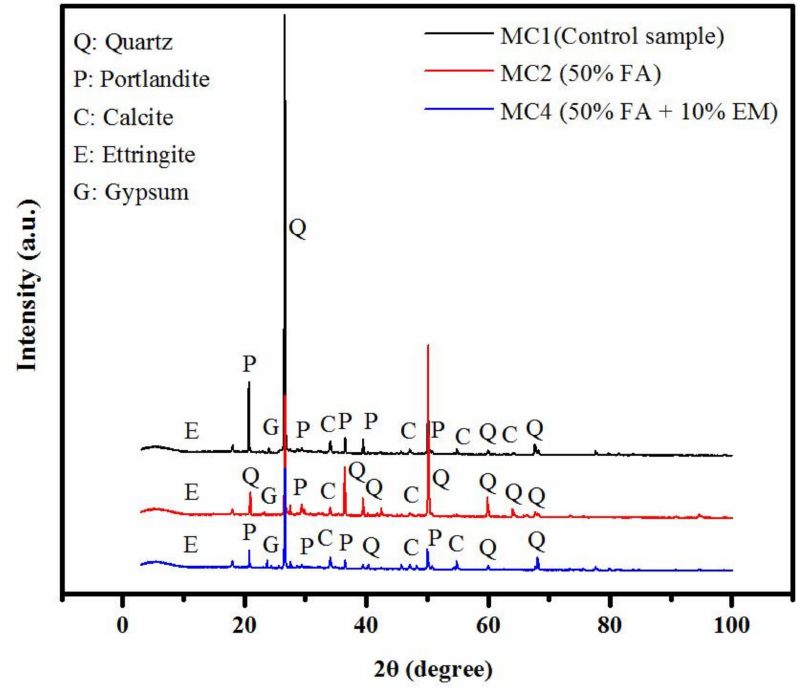
Figure 5. Effect of FA and EM content on XRD of prepared concrete specimens. Table 5. The XRD peak values for modified concrete with FA and EM, weight